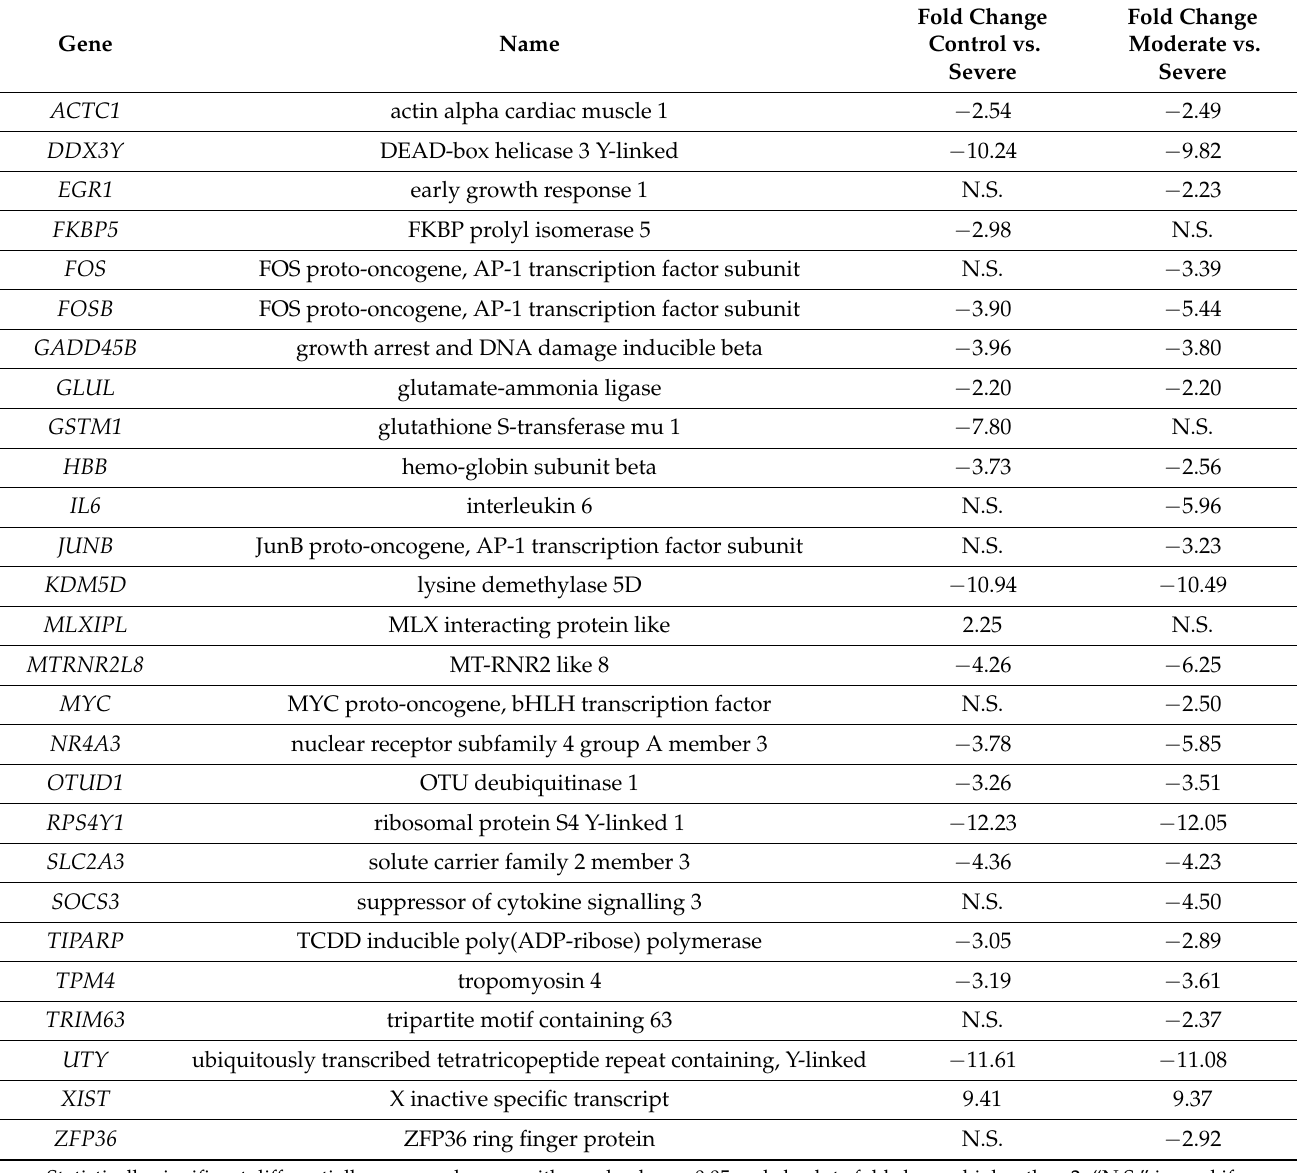
Table 2. Differentially expressed genes in control or moderate against severe